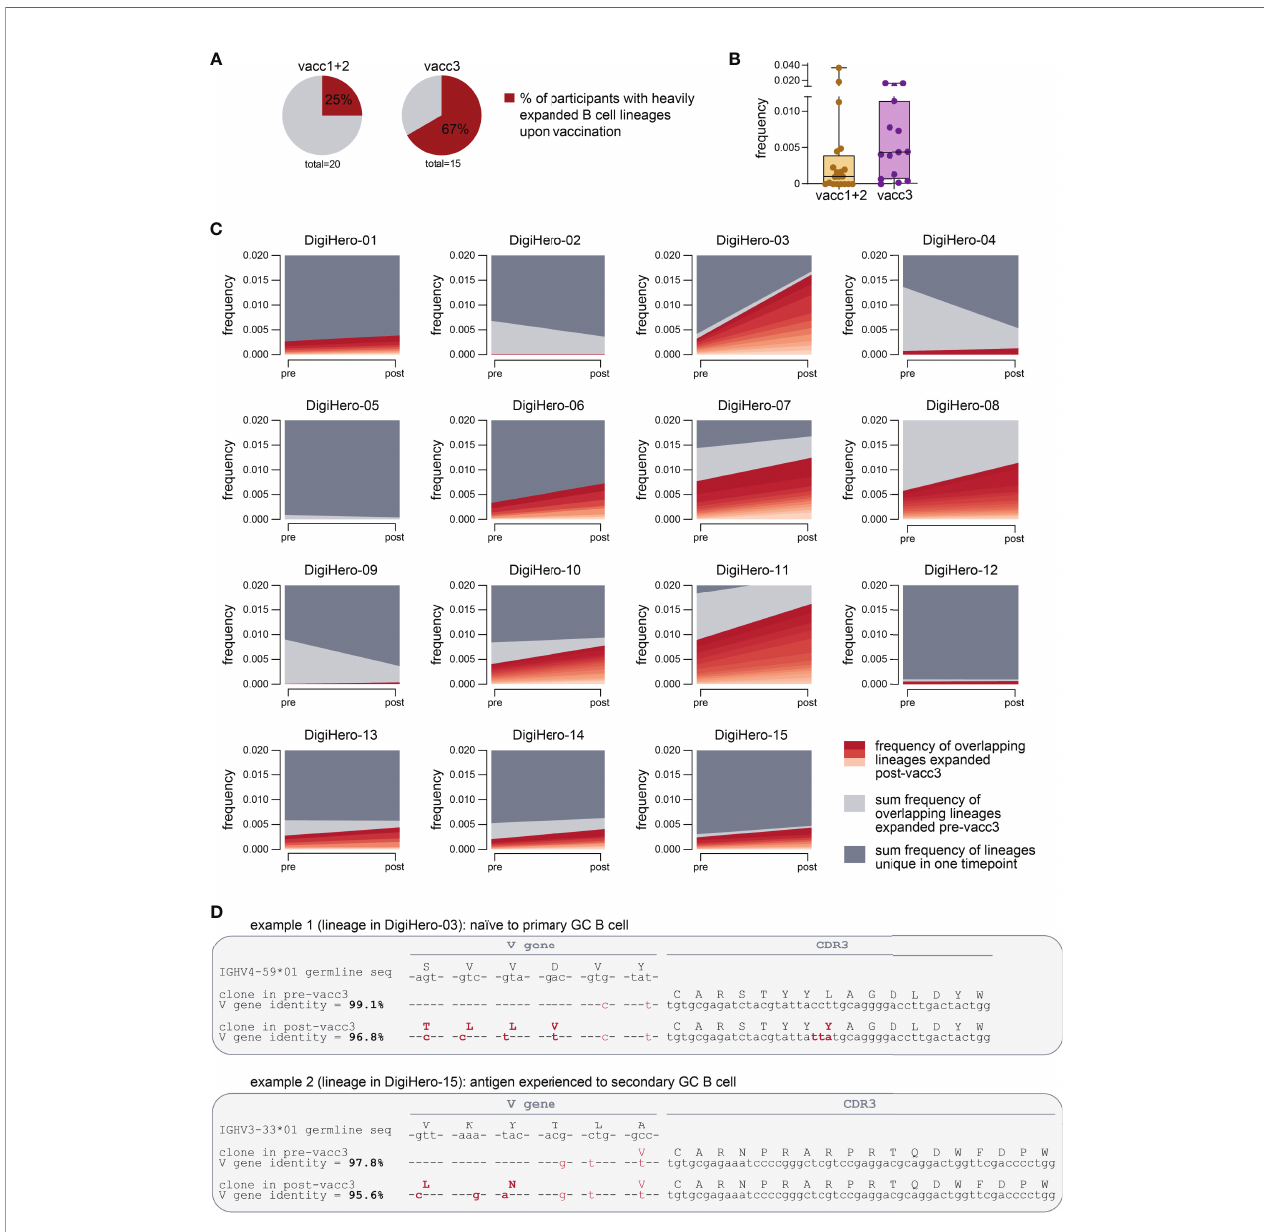
FIGURE 5 | Expanding B cell lineages upon vaccination. B cell lineages in individual patients pre- and post-vaccination were constructed based on V and J gene identity as well as CDR3 sequence homology. (A) The percentage of participants with heavily expanded B cell lineages (more than 0.3% frequency within the post-vaccination repertoire taken up by overlapping expanded lineages) after the fi rst/second (vacc1+2) or third vaccination (vacc3) are shown as pie charts. (B) Repertoire frequency of expanding B cell lineages at the post-vaccination time point. (C) Stream plots showing expanding B cell lineages in patients receiving their third SARS-CoV-2 vaccination (vacc3). (D) Exemplary detailed somatic hypermutation analysis of two antibody sequences. GC = germinal center. Seq =